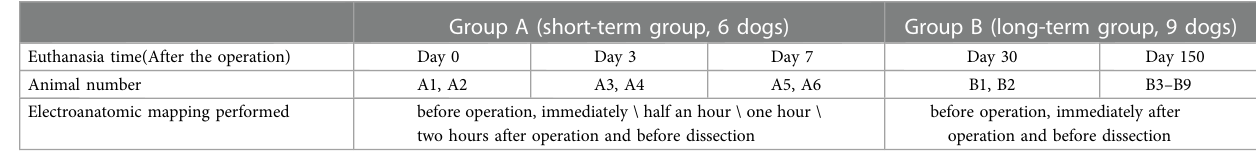
TABLE 1 Experimental grouping.